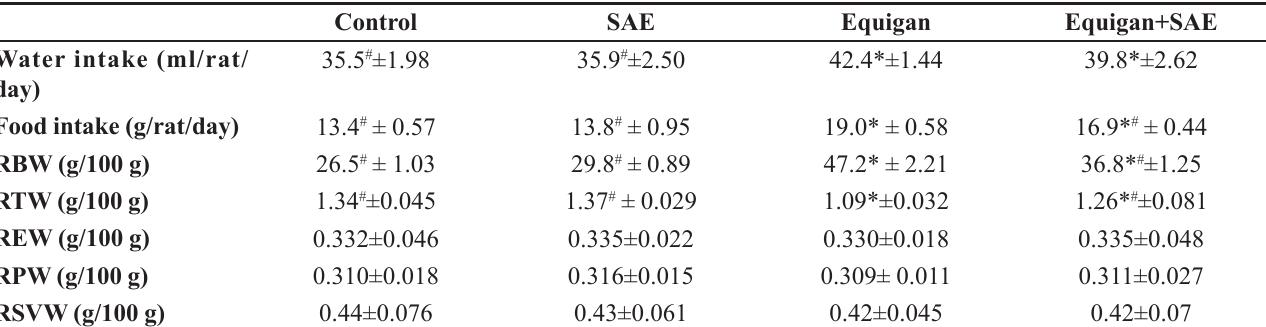
Value represents mean ± SE of 10 rats. Significant difference from the control group at * p < 0.05. Significant difference from Equigan group at # p < 0.05. Relative testes weights (RTW), relative Epididymis weights (REW), relative seminal vesicles weights (RSVW) and relative prostates weights (RPW).